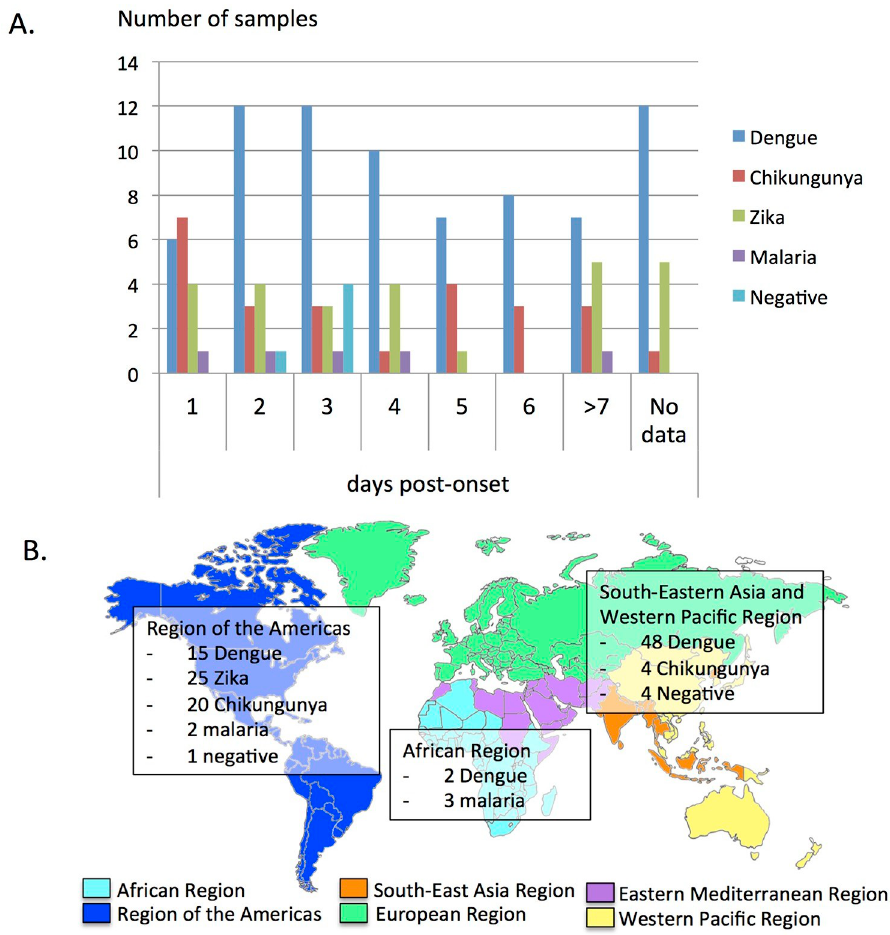
Fig 1. A. Distribution of samples by day post-onset of symptoms and final diagnosis. B. Distribution of samples by visited region, according to the WHO regions. In 11 samples (9 positive DENV samples, one positive ZIKV sample and one positive CHIKV sample) the country visited was not